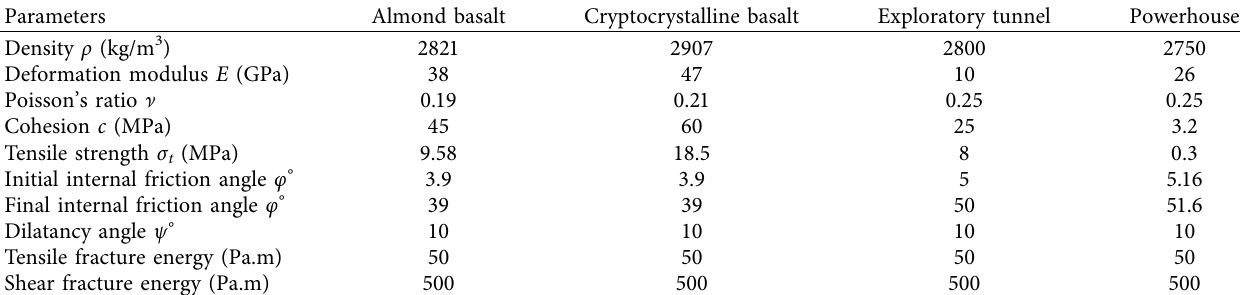
Table 7: Mechanical parameters under diferent simulation